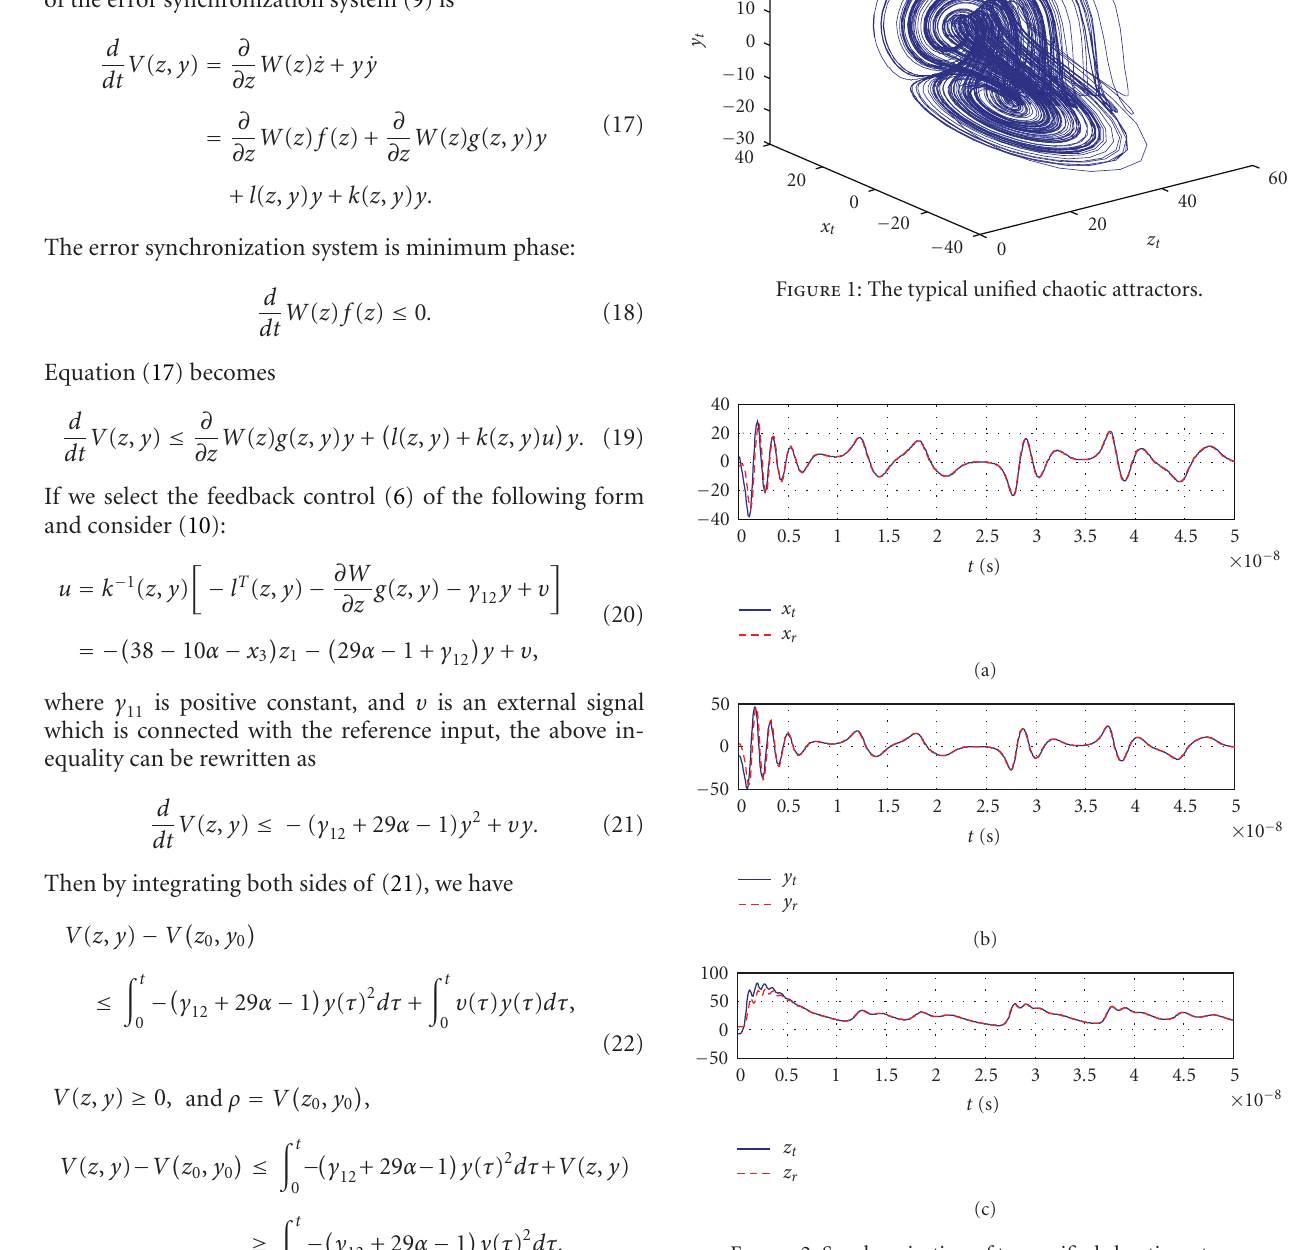
Figure 2: Synchronization of two unified chaotic systems.